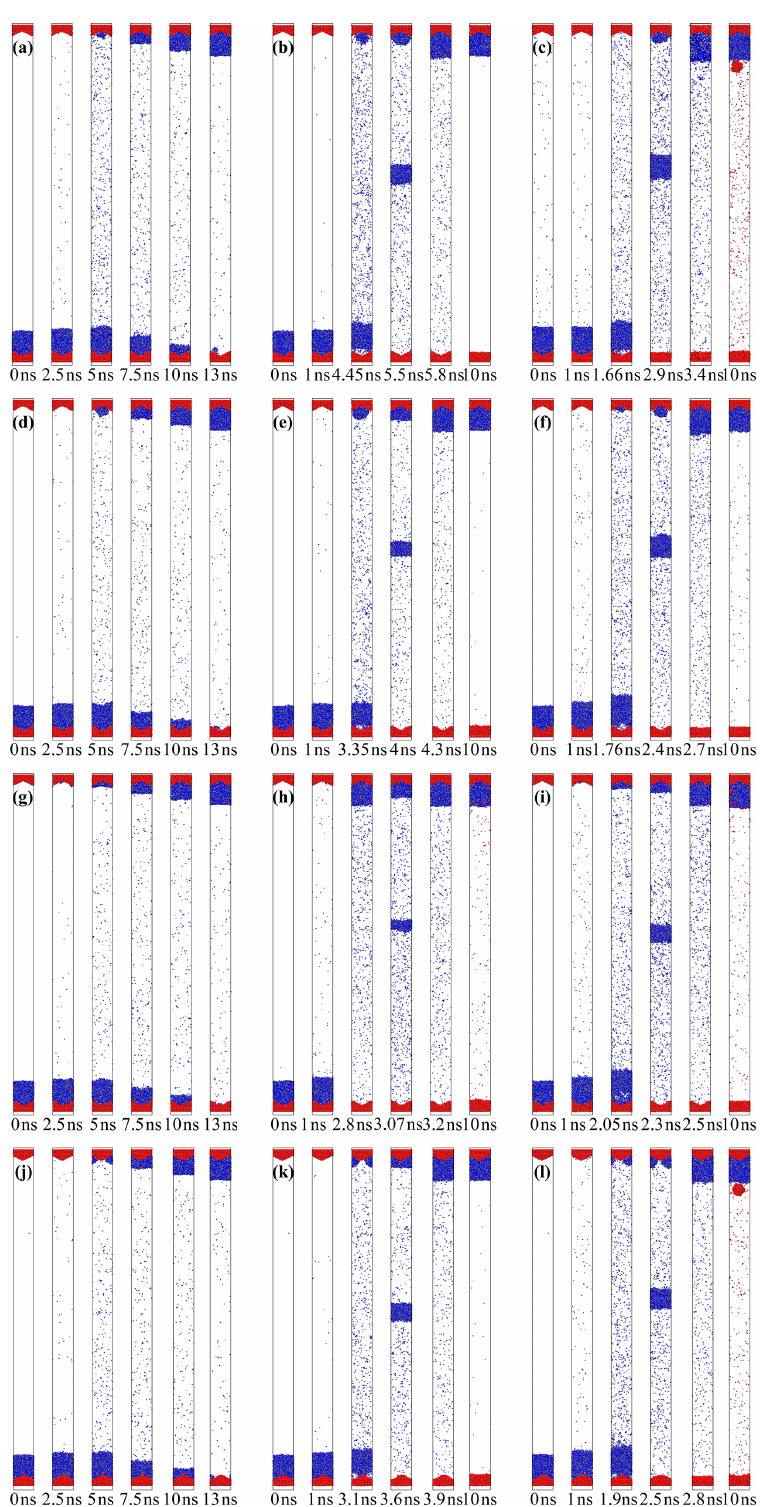
Figure 3. Snapshots of atom distribution at representative time points for cases ( a ) no. 1 (Surface − 1, 0.75 (cid:101) 0 , q 0 ), ( b ) no. 3 (Surface − 1, 0.75 (cid:101) 0 , 2 q 0 ), ( c ) no. 4 (Surface − 1, 0.75 (cid:101) 0 , O − Cu O − Cu O − Cu 6 q 0 ), ( d ). no. 5 (Surface − 1, (cid:101) 0 , q 0 ), ( e ) no. 7 (Surface − 1, (cid:101) 0 , 3.5 q 0 ), ( f ) no. 8 (Surface − 1, O − Cu O − Cu (cid:101) 0 , 6 q 0 ), ( g ) no. 9 (Surface − 1, 2 (cid:101) 0 , q 0 ), ( h ) no. 11 (Surface − 1, 2 (cid:101) 0 , 5 q 0 ), ( i ) no. 12 O − Cu O − Cu O − Cu (Surface − 1, 2 (cid:101) 0 , 6 q 0 ), ( j ) no. 17 (Surface 1, (cid:101) 0 , q 0 ), ( k ) no. 19 (Surface 1, (cid:101) 0 , 3.5 q 0 ), and O − Cu O − Cu O − Cu ( l ) no. 20 (Surface 1, (cid:101) 0 , 6 q 0 O − Cu